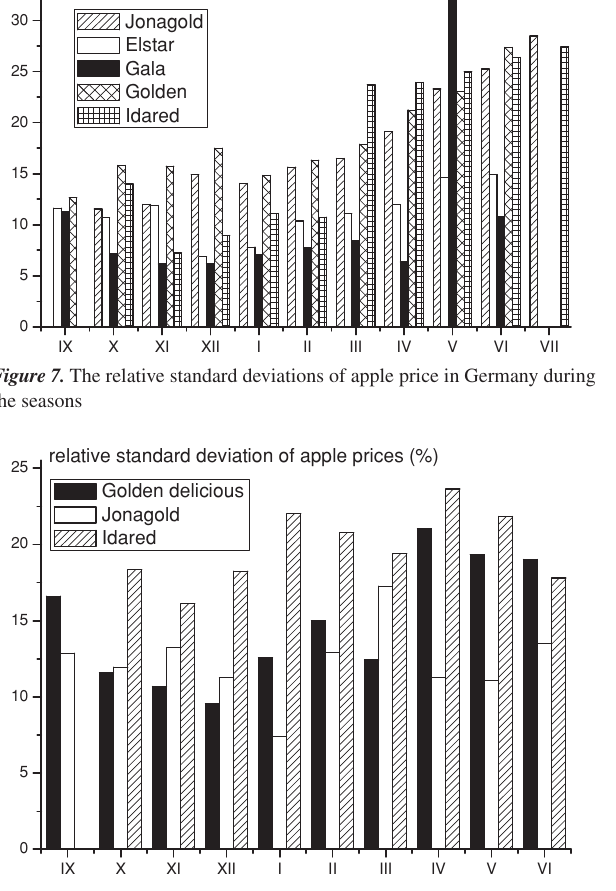
Figure 8. The relative standard deviations of apple price in Hungary during the seasons